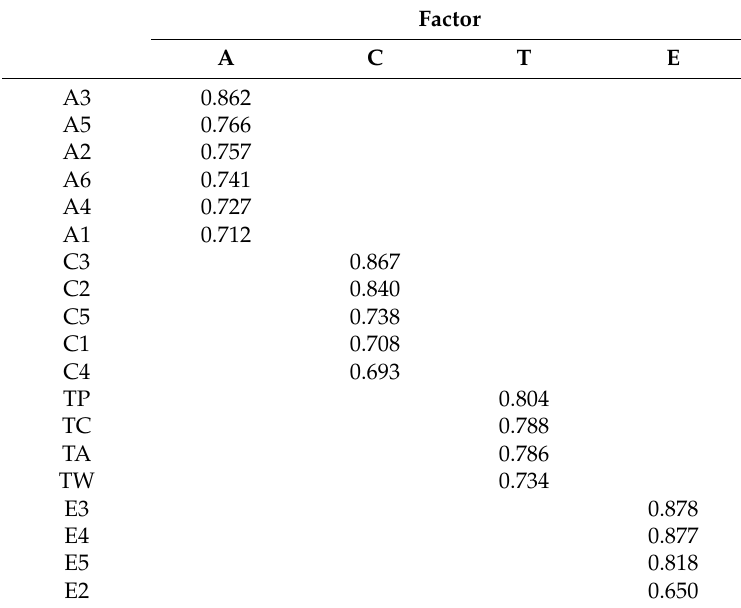
Table 2. Factor loading